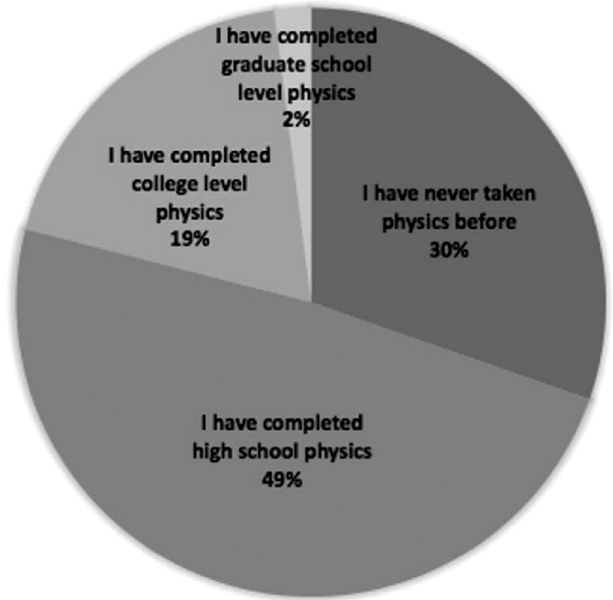
FIG. 8. Level of physics background of Mechanical Turk participants in the study ( N ¼ 300